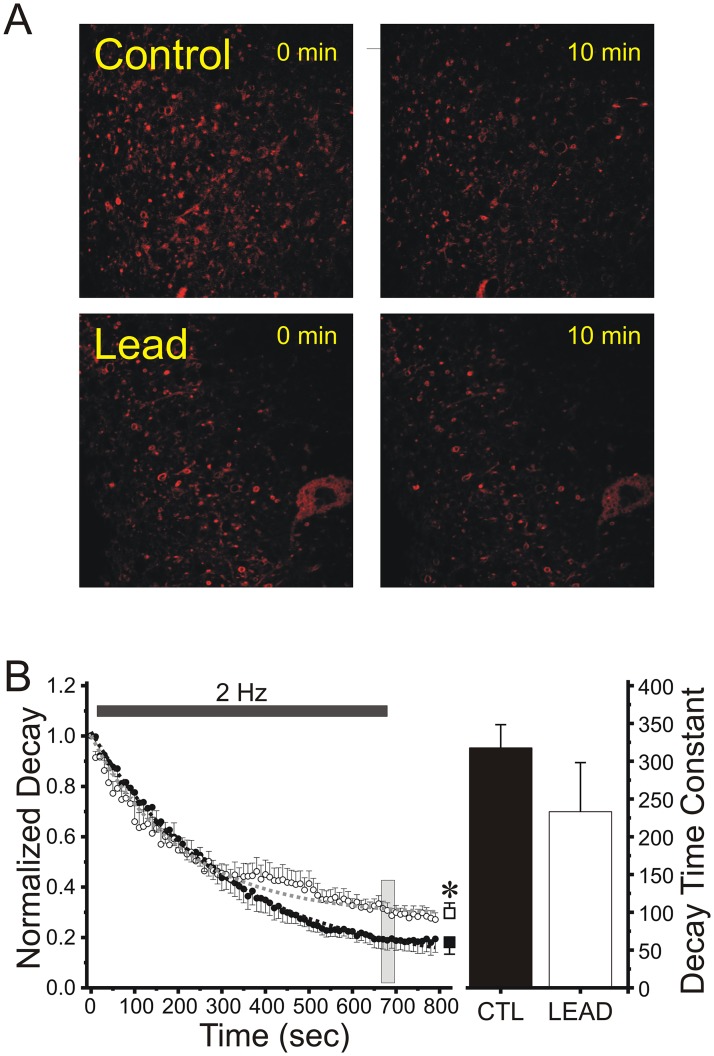
Two-photon laser scanning microscopic (TPLSM) images of FM1-43 vesicular release from Mossy fiber terminals in field CA3 of hippocampal slices confirm that release probability is reduced by chronic Pb2+ exposure.(A) Representative TPLSM pseudocolor images of FM1-43 loaded presynaptic terminals in proximal stratum radiatum of field CA3c in hippocampal slices from Pb2+-treated (Lead) and Control rats imaged prior to (0 min) and after 10 minutes (10 min) of 2Hz Mossy fiber stimulation (Calibration Bar: 5 μm). (B) Time course (Mean ± SEM) of stimulus-evoked FM1-43 destaining from large Mossy fiber puncta in field CA3 of hippocampal slices in response to 2Hz Schaffer collateral stimulation (solid bar) in control (solid circles, N = 5 slices, 25 puncta) versus chronically Pb2+-treated (open circles, N = 6 slices, 27 puncta) rats. Overall, decay time constants were not statistically significantly smaller in slices from Pb2+-treated rats (white bars) compared to those from control rats (black bars). However, a significant effect of Pb2+ was observed at the later time points in the 2Hz train (gray bar; * P < 0.05, Student’s t-test comparing open and black squares).